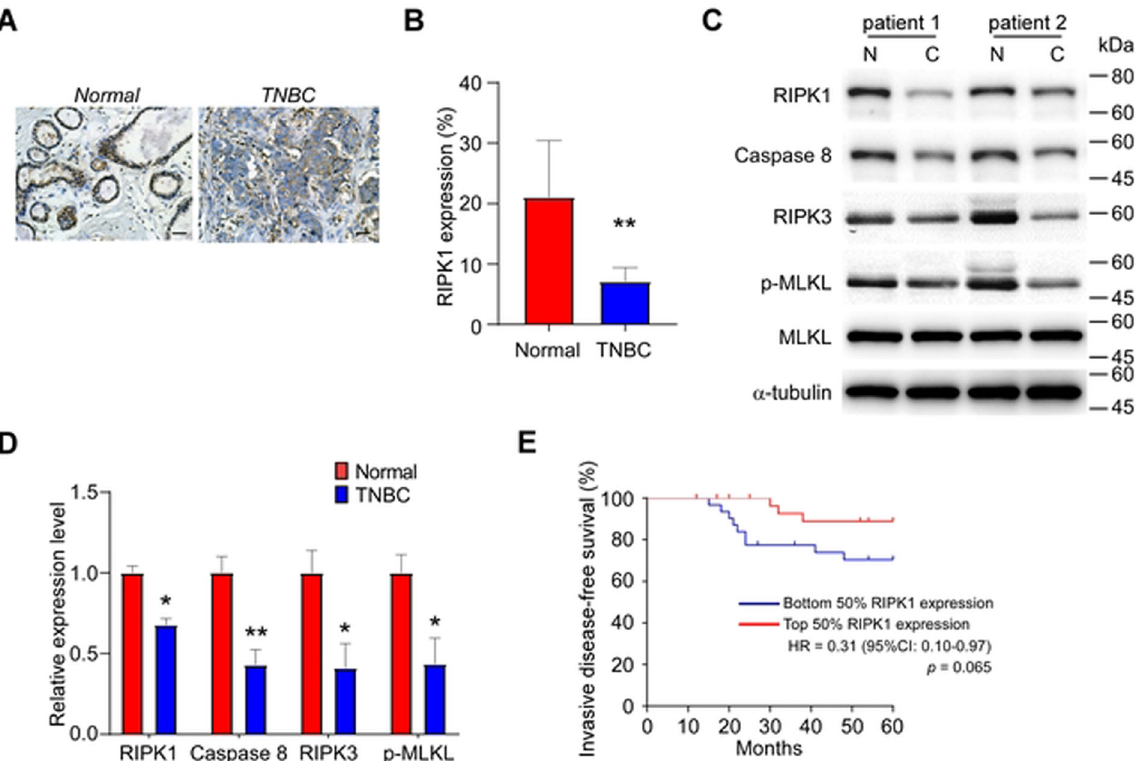
Fig. 2 RIPK1 is downregulated in TNBC and associated with enhanced survival. A Representative images of anti-RIPK1 immunohis- tochemistry staining of TNBC and normal breast tissue (×200 magni fi cation). Scale bar : 40 μ m. B Quanti fi cation of the RIPK1-positive cell percentage in TNBC and normal breast tissue ( n = 62). C Representative blotting of Western blot analysis of TNBC and normal breast tissue. Abbreviations : N, normal breast tissue; C, TNBC. D Quanti fi cation of relative expression levels of RIPK1, Caspase-8, RIPK3, and phospho-MLKL (p- MLKL) in TNBC and normal breast tissue ( n = 62). E Kaplan – Meier survival plot showing the invasive-disease-free survival of TNBC patients in the current cohort strati fi ed by dichotomic expression levels of AQP1 ( n = 31 for each group). Note : * p < 0.05, ** p <